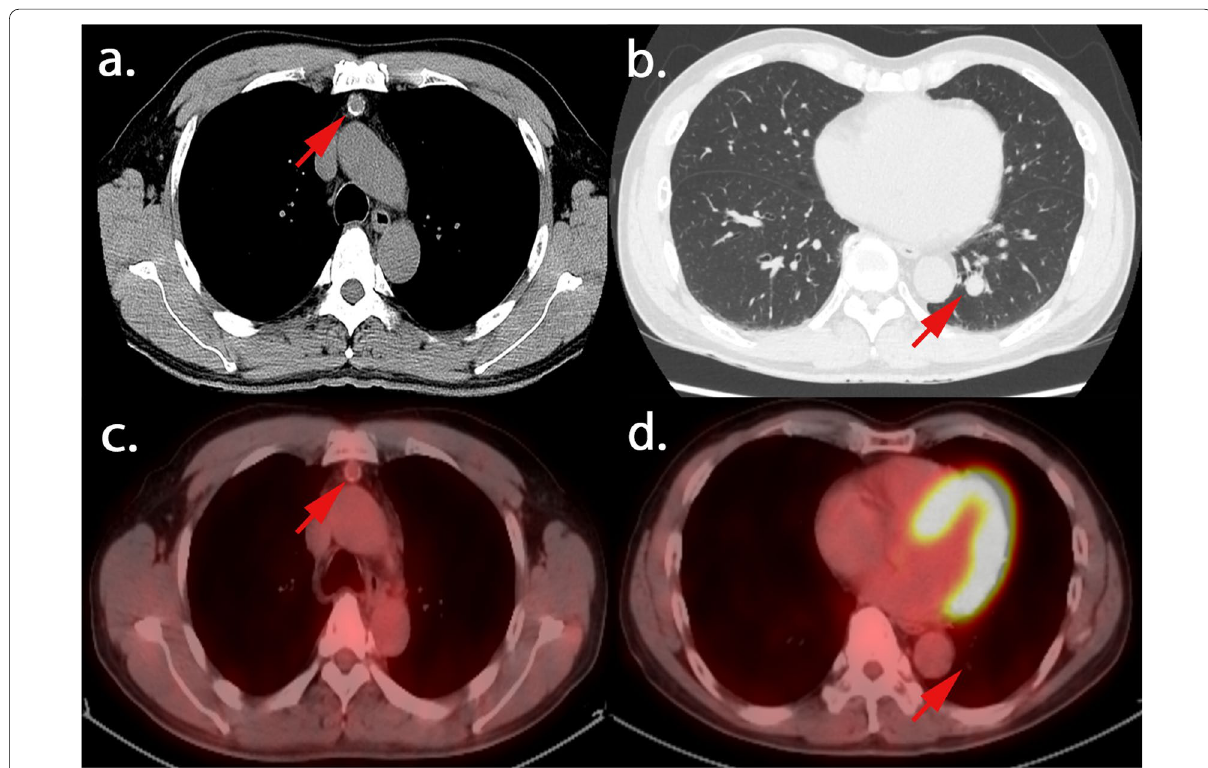
Fig. 1 a , b Chest computed tomography findings. A tumor with calcification is located in the anterior mediastinum ( a ) and a well-defined hilar nodule is located in S 10 of the left lung ( b ). c , d 18 F-fluorodexyglycose positron emission tomography/computed tomography findings. Uptake is noted in the anterior mediastinal tumor (SUV max 1.5) ( c ), but no significant uptake is noted in the pulmonary nodule (SUV max =